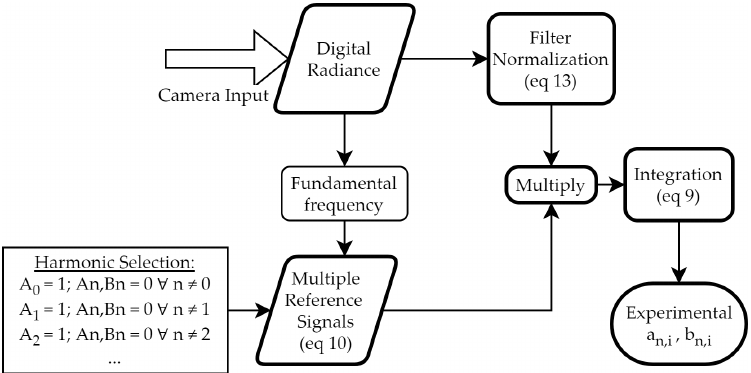
Figure 3. Flowchart of the post-processed lock-in